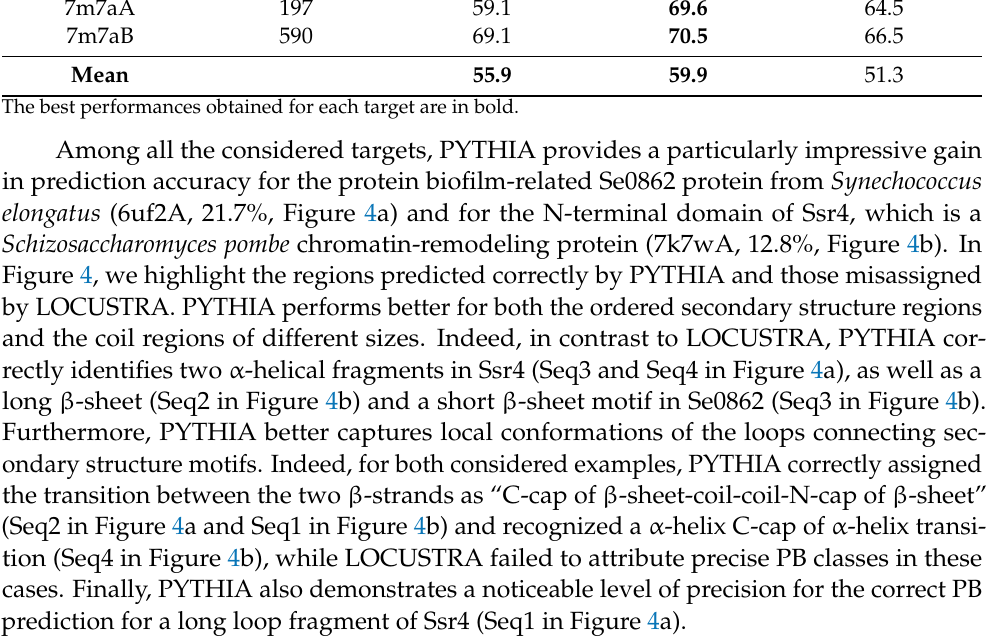
PYTHIA LOCUSTRA